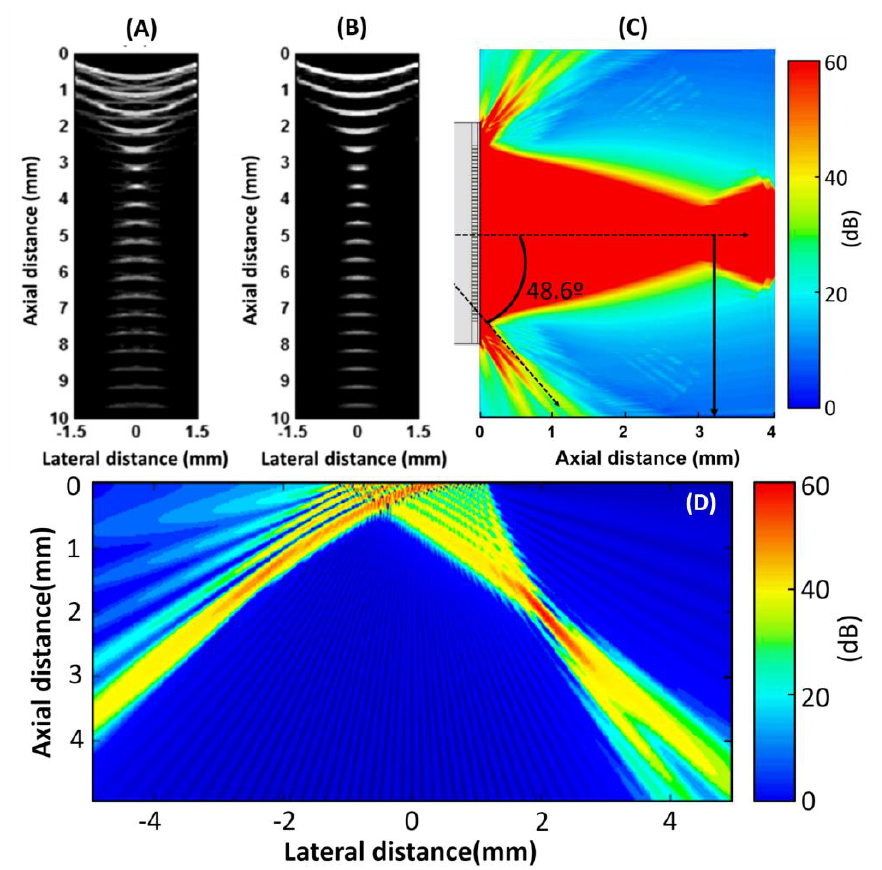
Figure 7. Point spread function phantom-imaged ( A ) without and ( B ) with apodization. ( C ) Simulated phased array acoustic pressure of emission mode when the steering angle is 0 ◦ . ( D ) Simulated acoustic beam generated by the 48-element phased array when the steering angle is 45 ◦ and the focal distance is 3 mm.